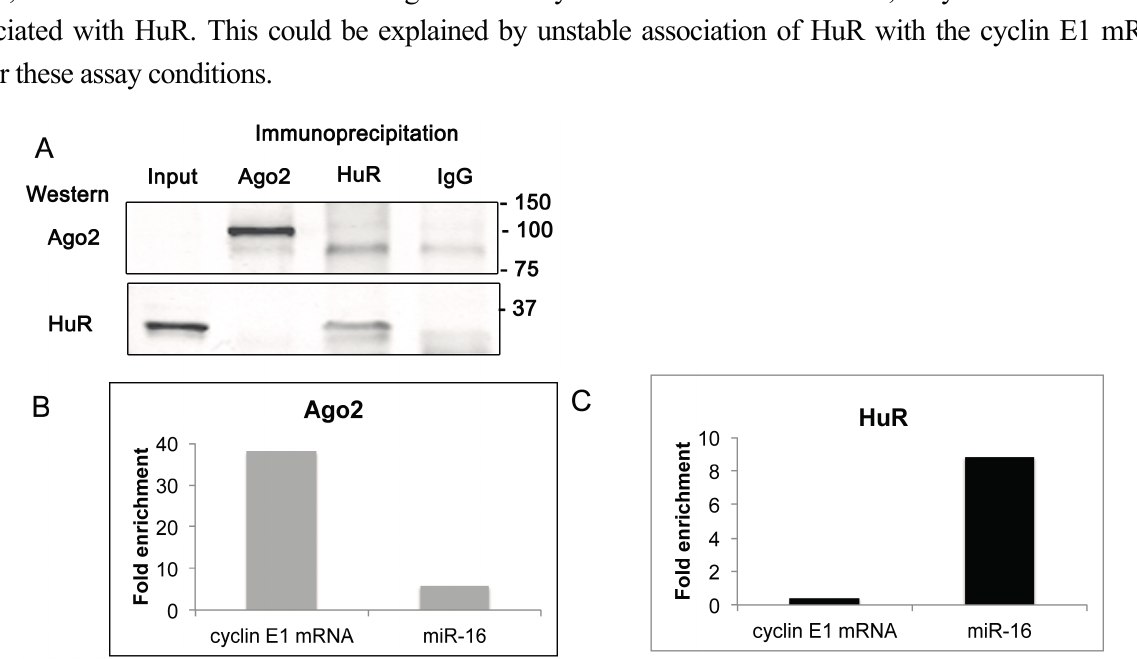
Figure 6. Cyclin E1 mRNA associates with Ago2. Immunoprecipitation of endogenous Ago2 or HuR was performed on untransfected MCF-7 cell extracts. ( A ) Western analysis for proteins precipitated with antibodies specific for Ago2, HuR, or nonspecific IgG. 40- μ g of cell lysate was resolved in the Input lane. Blot was probed using anti-Ago2 and anti-HuR sequentially and imaged on a Li-Cor imager. Molecular weight markers are indicated to the right. The uncropped blot as well as a blot from a separate experiment is shown in Figure S1; ( B ) Immunoprecipitation with antibodies to Ago2 followed by qRT-PCR for cyclin E1 mRNA or miR-16. Expression was normalized to input and fold enrichment compared to immunoprecipitation with IgG is shown; and ( C ) Immunoprecipitation with antibodies to HuR followed by qRT-PCR for cyclin E1 mRNA or miR-16. Expression was normalized to input and fold enrichment compared to immunoprecipitation with IgG is shown. A representative experiment of three with similar results is